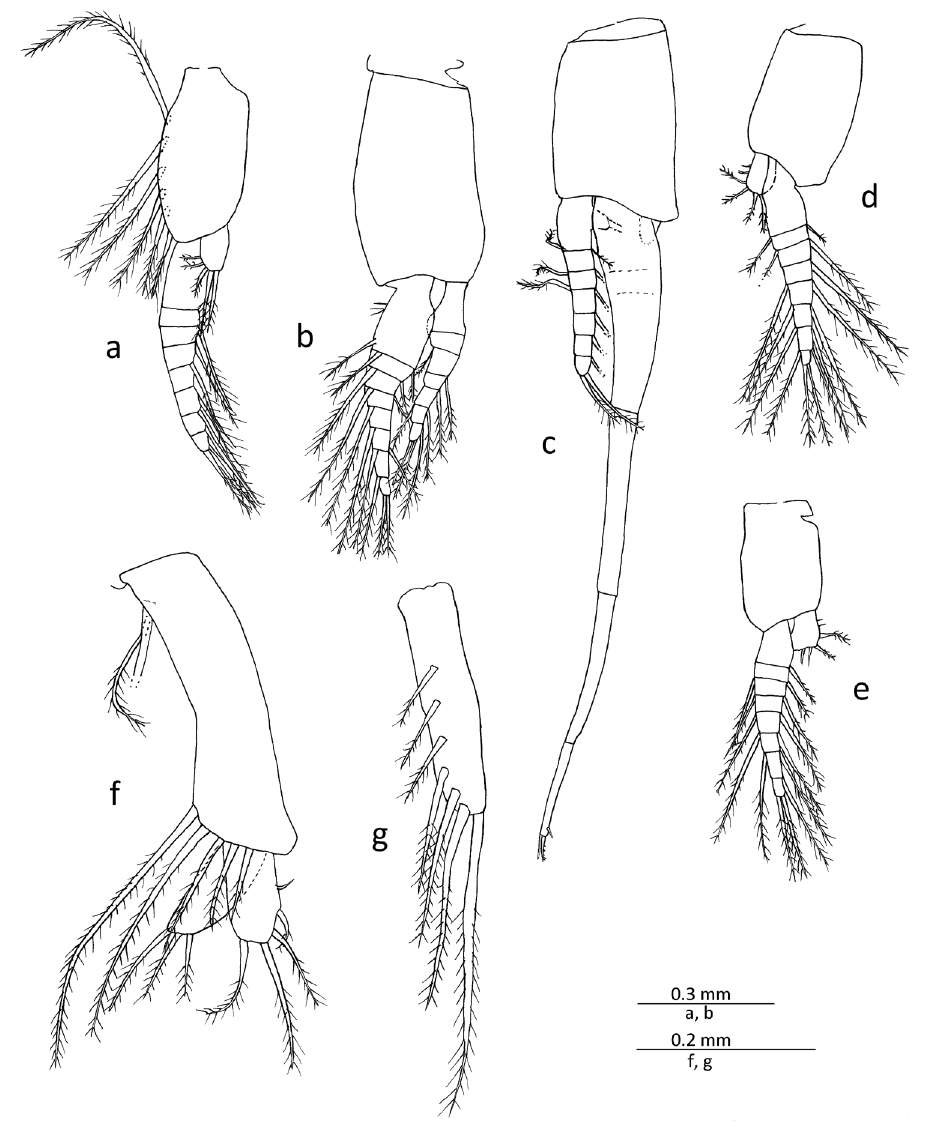
Figure 5. Gastrosaccus lombokiensis sp. n., paratype male (TL ca. 7.5 mm) ( a−e ) and paratype female (TL ca. 7.5 mm) ( f, g ): a right male first pleopod, mesial view b right male second pleopod, mesial view c right male third pleopod, lateral view d right male fourth pleopod, lateral view e right male fifth pleopod, me- sial view f right first female pleopod, mesial view g right female third pleopod, mesial view.